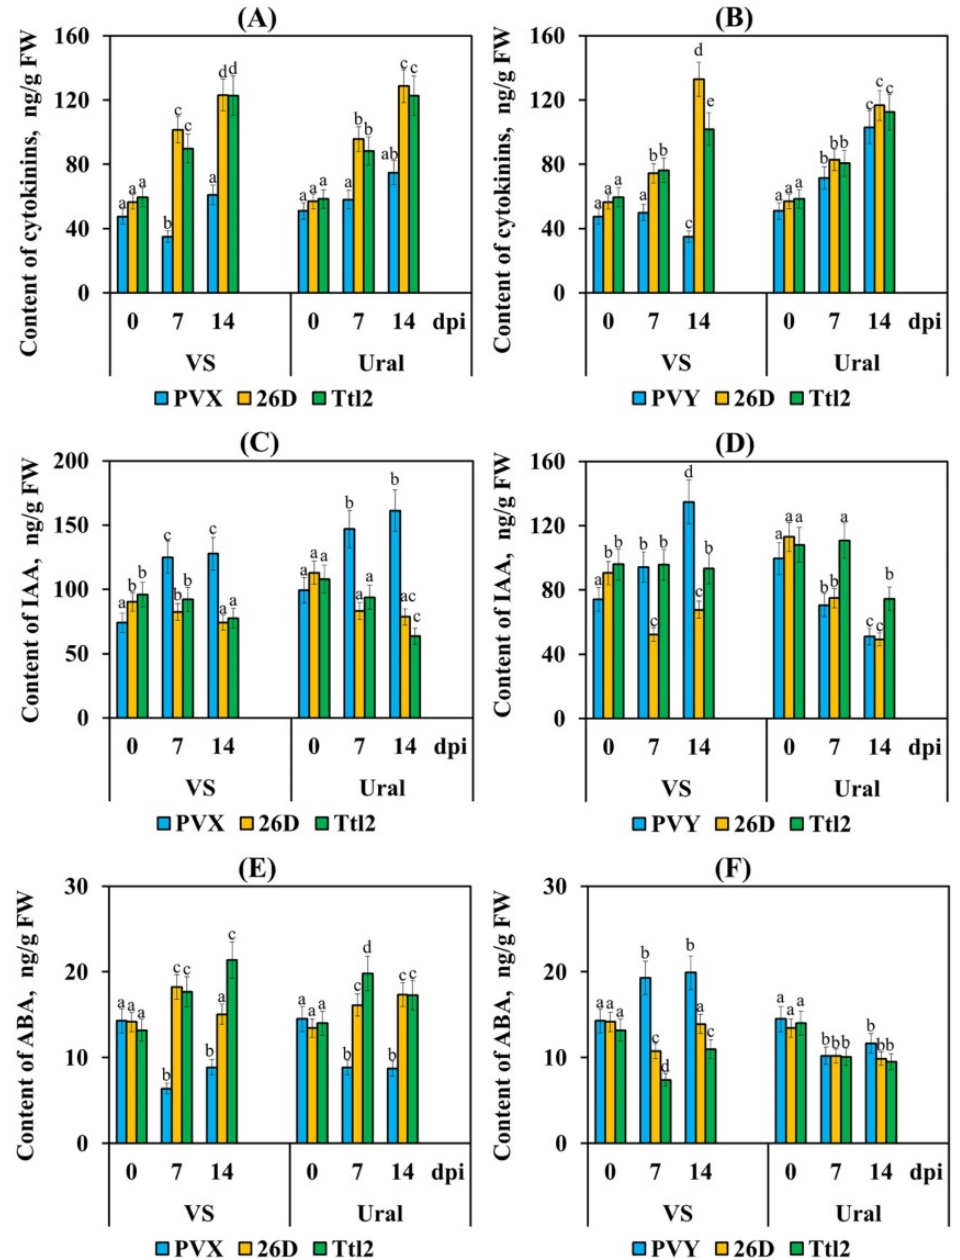
Figure 8. Influence of the endophytic strains B. subtilis 26D and B. subtilis Ttl2 on the content of active cytokinins (zeatin + zeatin riboside) ( A , B ), IAA ( C , D ) and ABA ( E , F ) in tomato plants of the varieties Volovye Serdtse (VS) and Ural infected with PVX ( A , C , E ) and PVY ( B , D , F ). The samples are indicated as follows: 0 dpi, control non-infected plants; PVX, plants infected with potato virus X; PVY, plants infected with potato virus Y; 26D, plants treated with B. subtilis 26D; Ttl2, plants treated with B. subtilis Ttl2. The figures present means ± SE (n = 6). The treatments marked with different Latin letters in one cultivar are statistically different from the control ones (0 dpi, not infected with viruses and not treated with bacteria) in each time-point, according to the LSD test ( p ≤